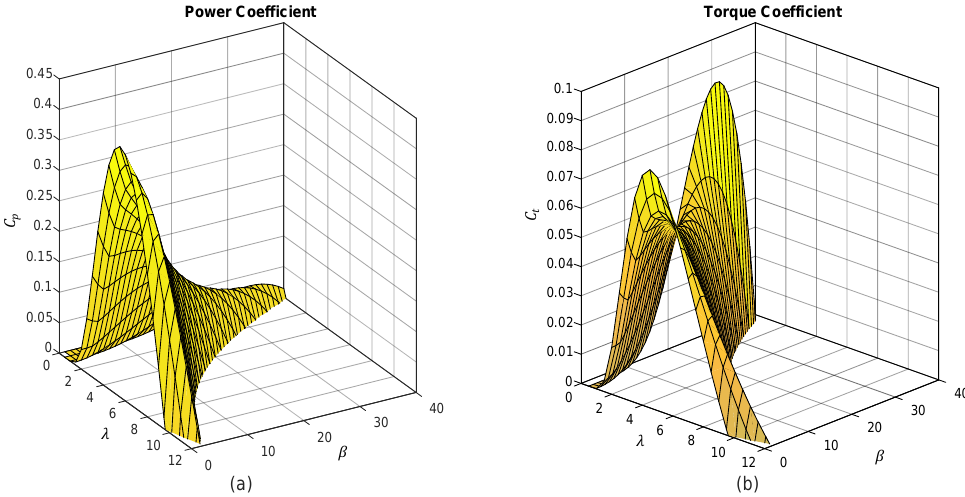
Figure 16. Coefficient proposed by Llano, Tatlow, and McMahon [48], with variations of λ and β ; ( a ) power coefficient, ( b ) torque coefficient.